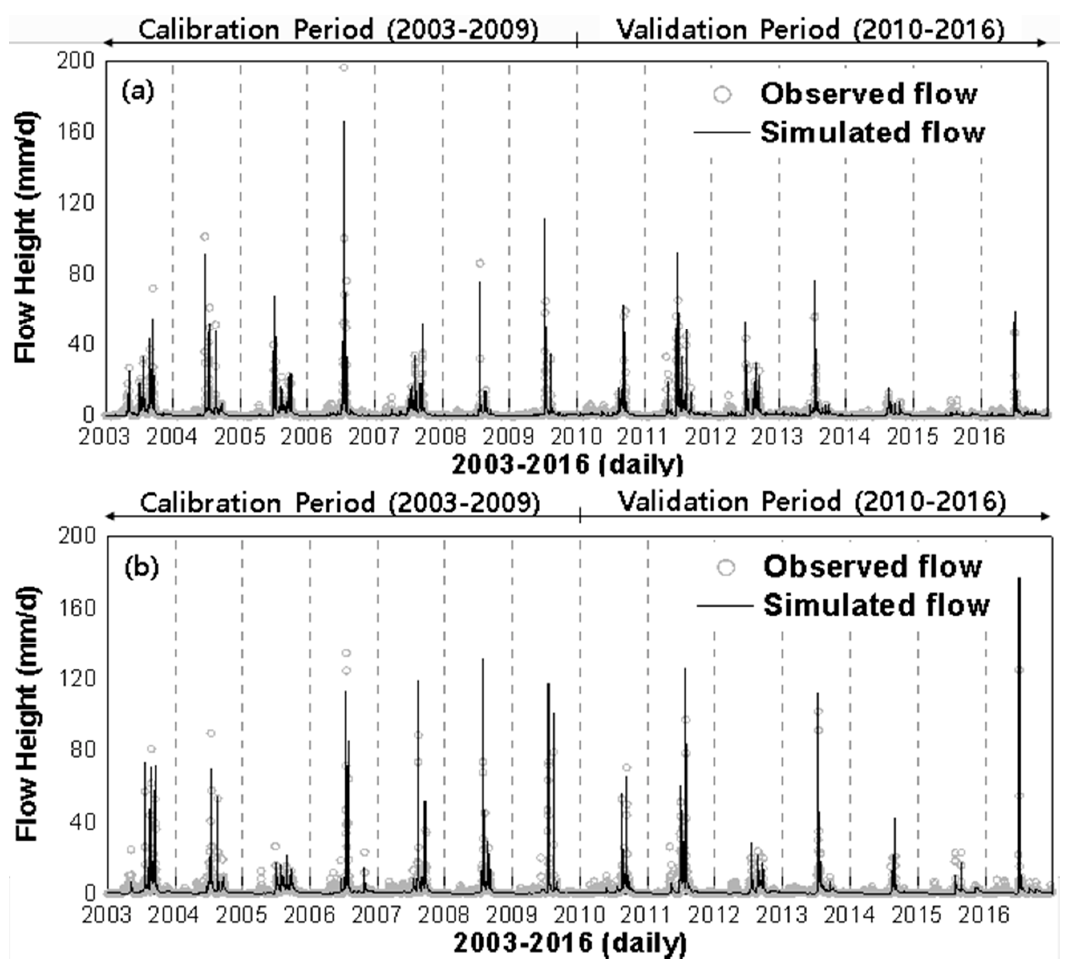
Figure 5. Hydrographs of upstream catchments for ( a ) Chungju Dam and ( b ) Soyanggang Dam. The gray circles are observations of daily dam inflow and black solid lines are simulated daily flow between 2003 and 2016. The years 2003–2009 are used for calibration, and 2010–2016 is the validation period.